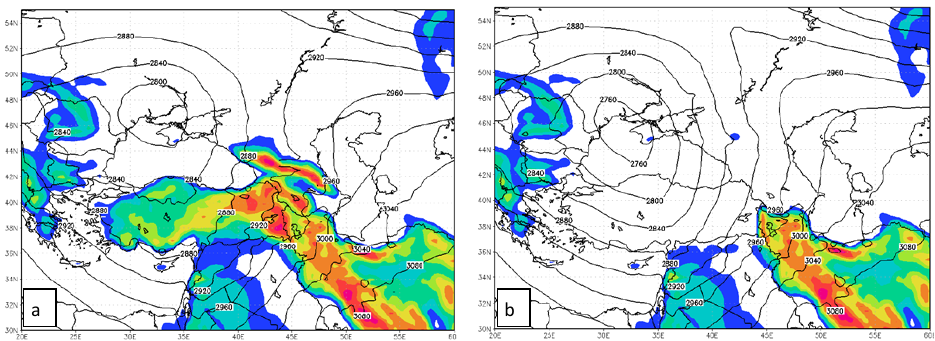
Fig.4.Forecasts of 700 hPa geopotential height (gpm) for 14 March 2009 at 0000 UTC for (a)